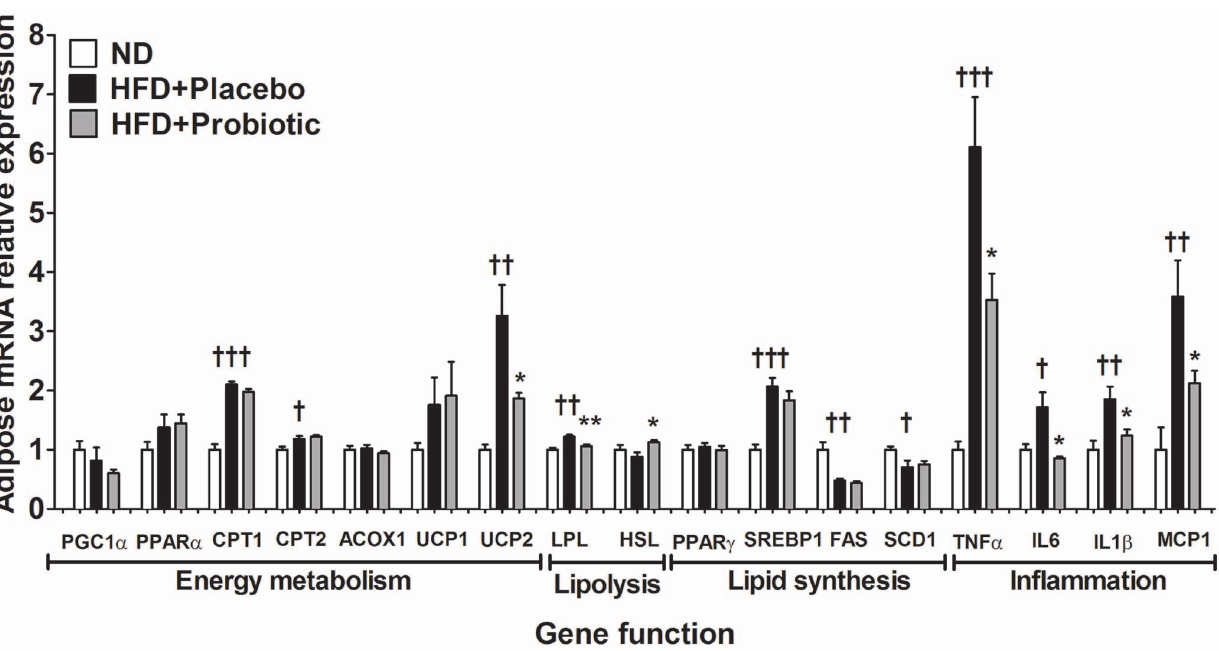
Figure 6. High-fat diet and probiotic effect on gene expression in epididymal fat. Results are expressed as the means 6 SE. Significant differences between HFD-placebo versus ND are indicated as { p , 0.05, {{ p , 0.01, {{{ p , 0.001. Significant differences between HFD + probiotic versus HFD + placebo are indicated as *p , 0.05, **p , 0.01, ***p , 0.001.